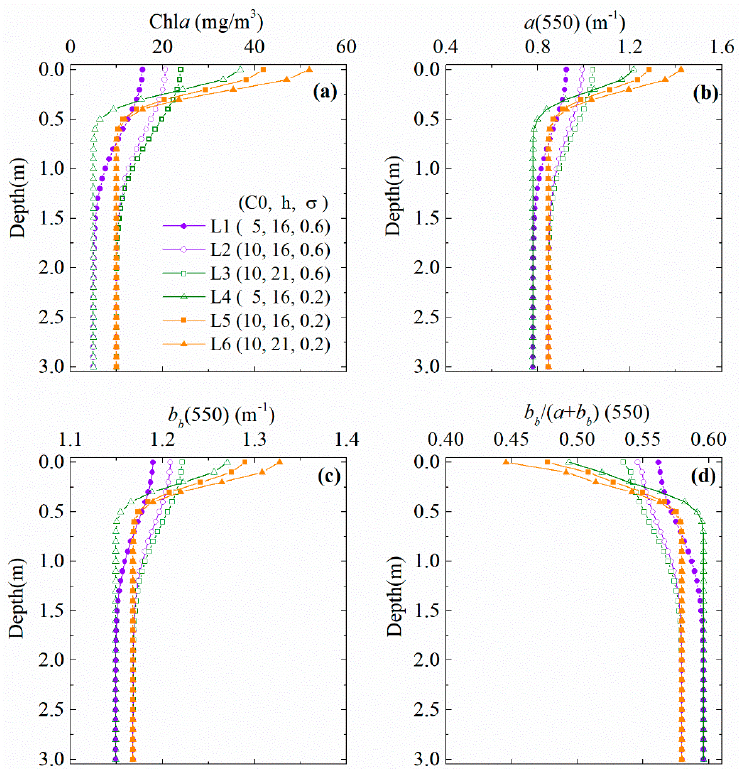
Figure 1. Bio-optical properties of six representative examples: ( a ) Chl a (z), ( b ) a (550), ( c ) b b (550), and ( d ) b b /( a + b b )(550). Different lines represent different vertical structure parameters (C 0 , h, σ ) of Chl a (z) profiles: L1 (5, 16, 0.6), L2 (10, 16, 0.6), L3 (10, 21, 0.6), L4 (5, 16, 0.2), L5 (10, 16, 0.2), L6 (10, 21, 0.2).